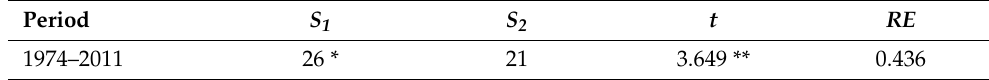
Table 3. Verification results of the canonical methods for the reconstruction.